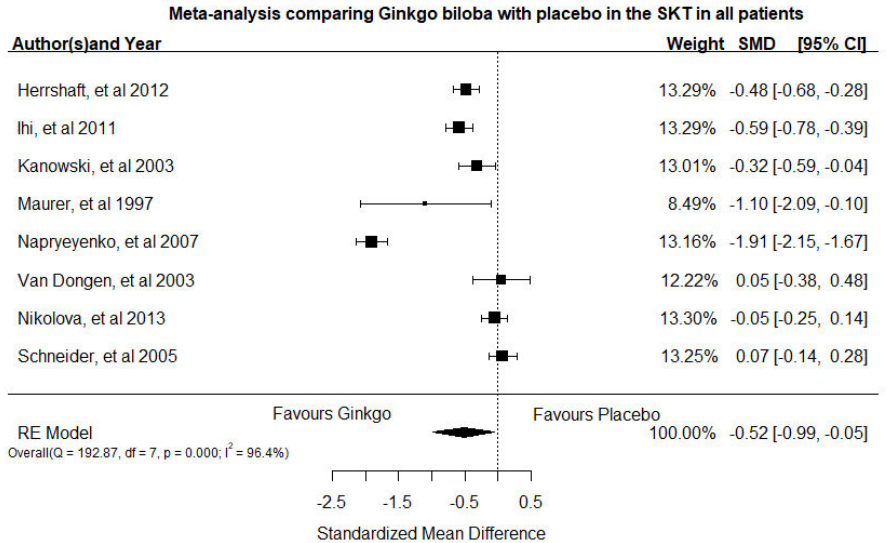
Figure 6. Forest plot of meta-analysis for EGb 761 ® 240 mg/die and placebo using random-effect model. Meta-analysis of the data obtained from the systematic literature review was conducted according to the guidelines of the Preferred Reporting Items for Systematic Reviews and Meta- analysis [116]. We searched the PubMed, MEDLINE, EMBASE, PsycINFO, CINAHL, Cochrane Database of Systematic Reviews with the terms Ginkgo* or Gingko* or EGB761 or “EGB 761” or EGB-761. For continuous data, standardized mean differences (SMD) was used. Given the expected heterogeneity, we a priori used a random-effects model. Overall, SMD with 95% CI was estimated with DerSimonian–Laird random-effects models. Publication bias was evaluated by a funnel plot and Egger’s linear regression analysis and p < 0.05 was set as the level of significant. This meta-analysis was performed using R